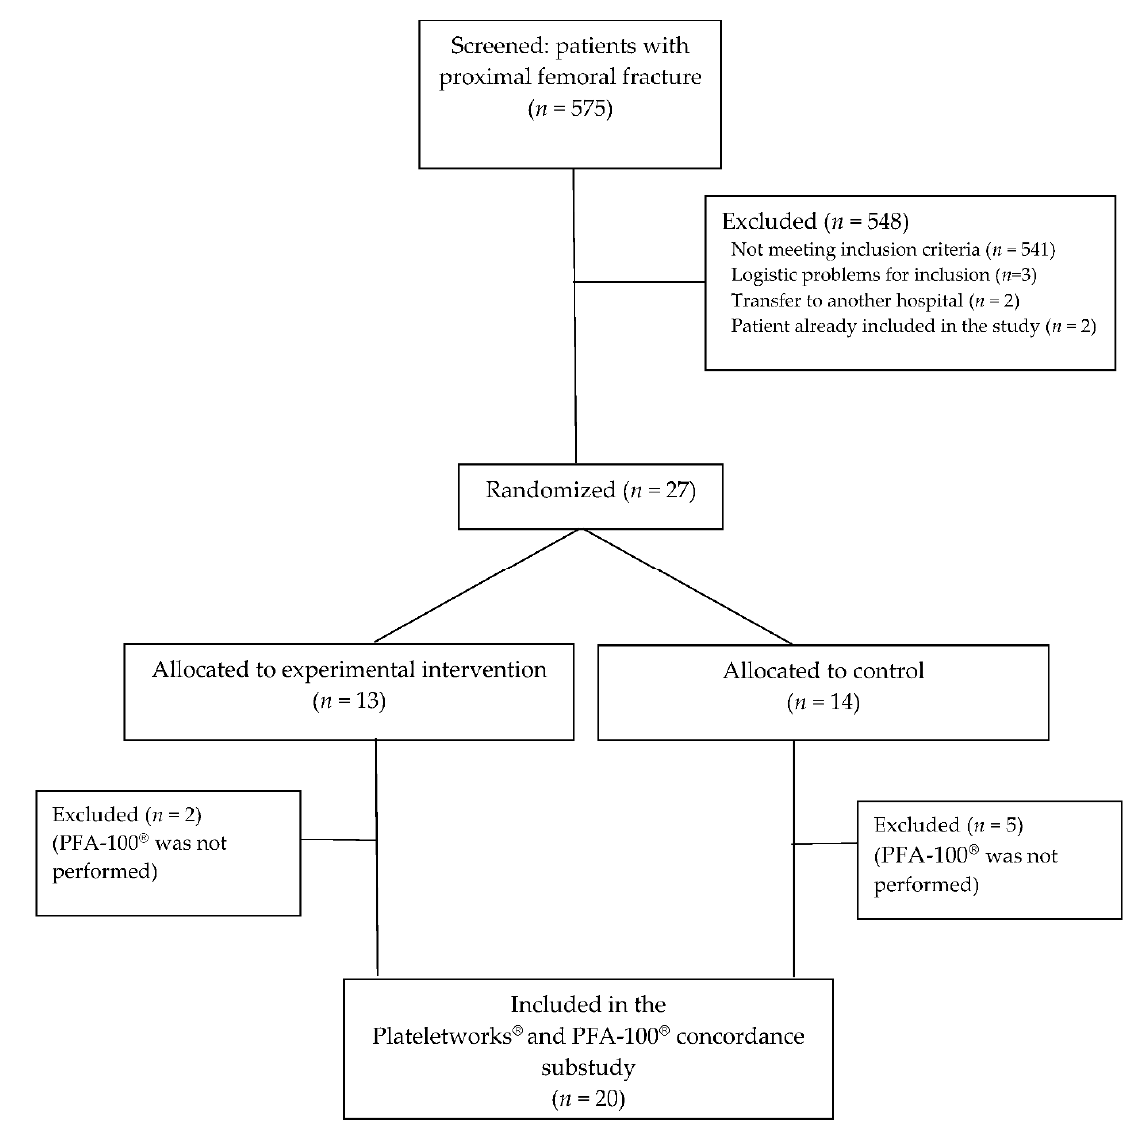
Figure 1. Flowchart of patients. Note: The randomization of patients for the main study was stratified by the center. This flowchart corresponds to the center that participated in the concordance sub-study until the number of patients was achieved.